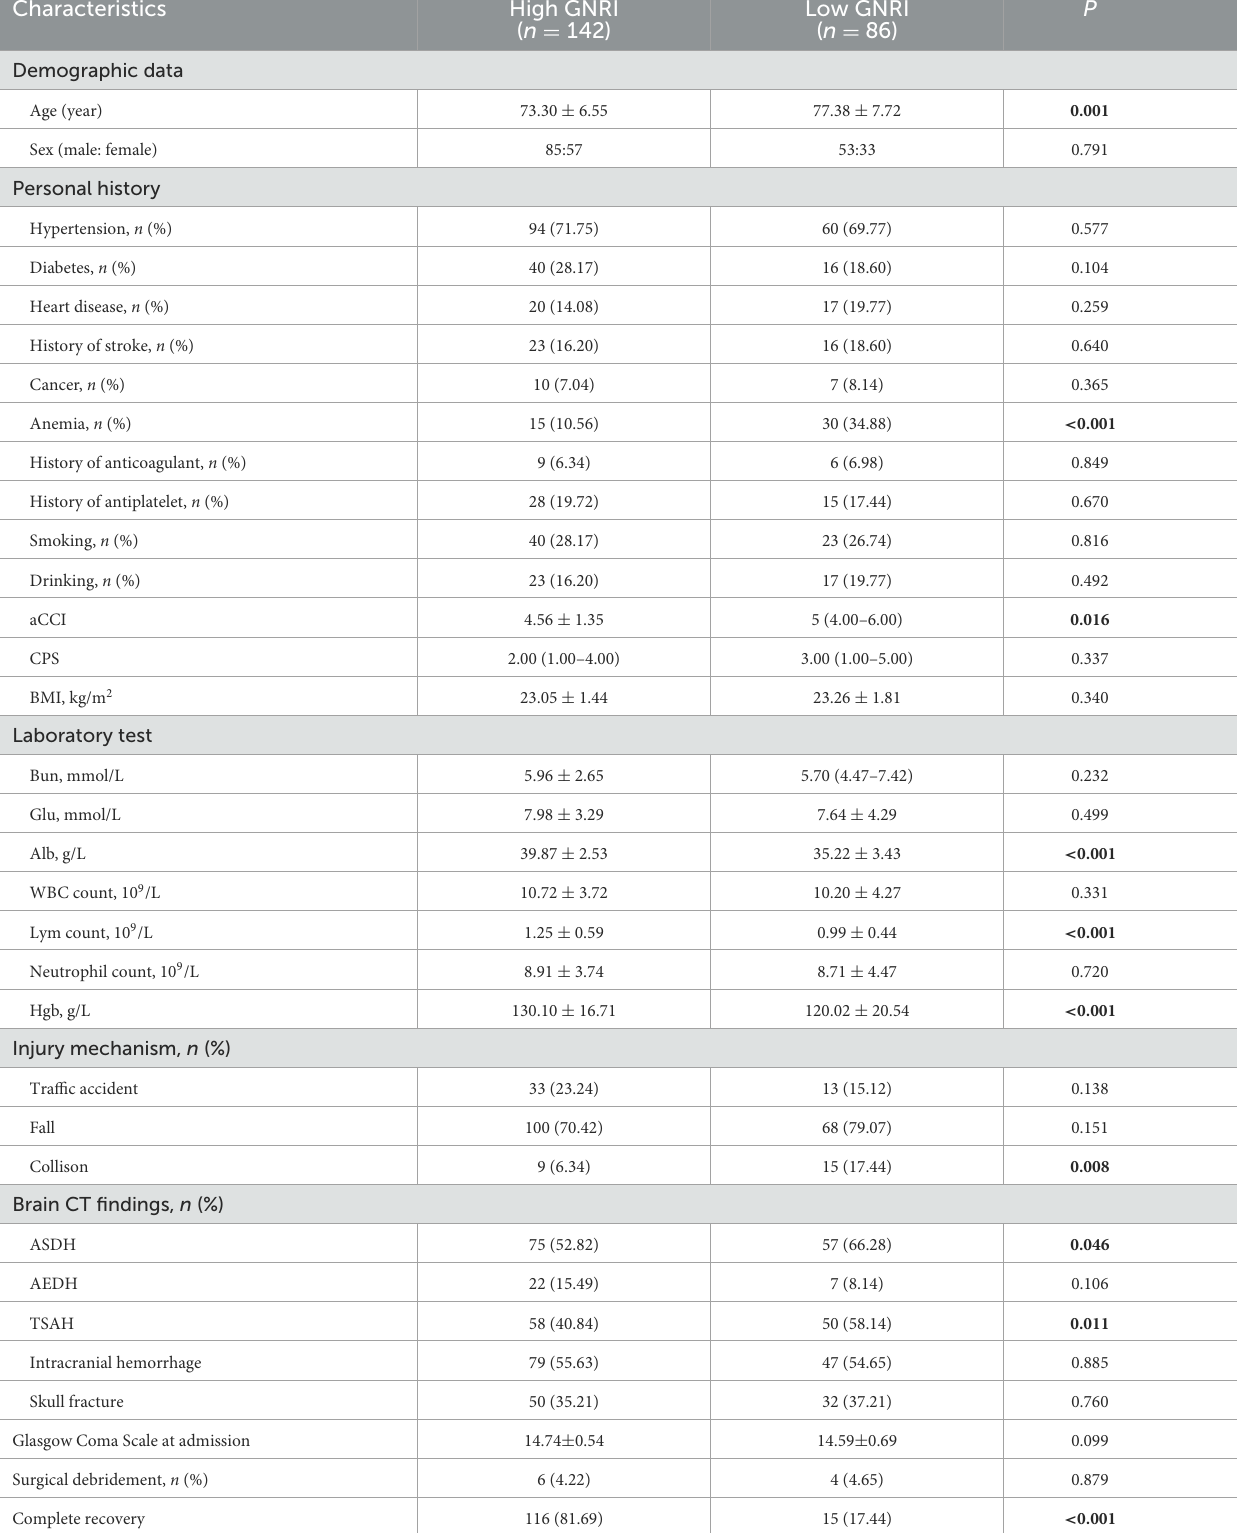
TABLE 2 Comparison of baseline characteristics between high GNRI patients and low GNRI patients.